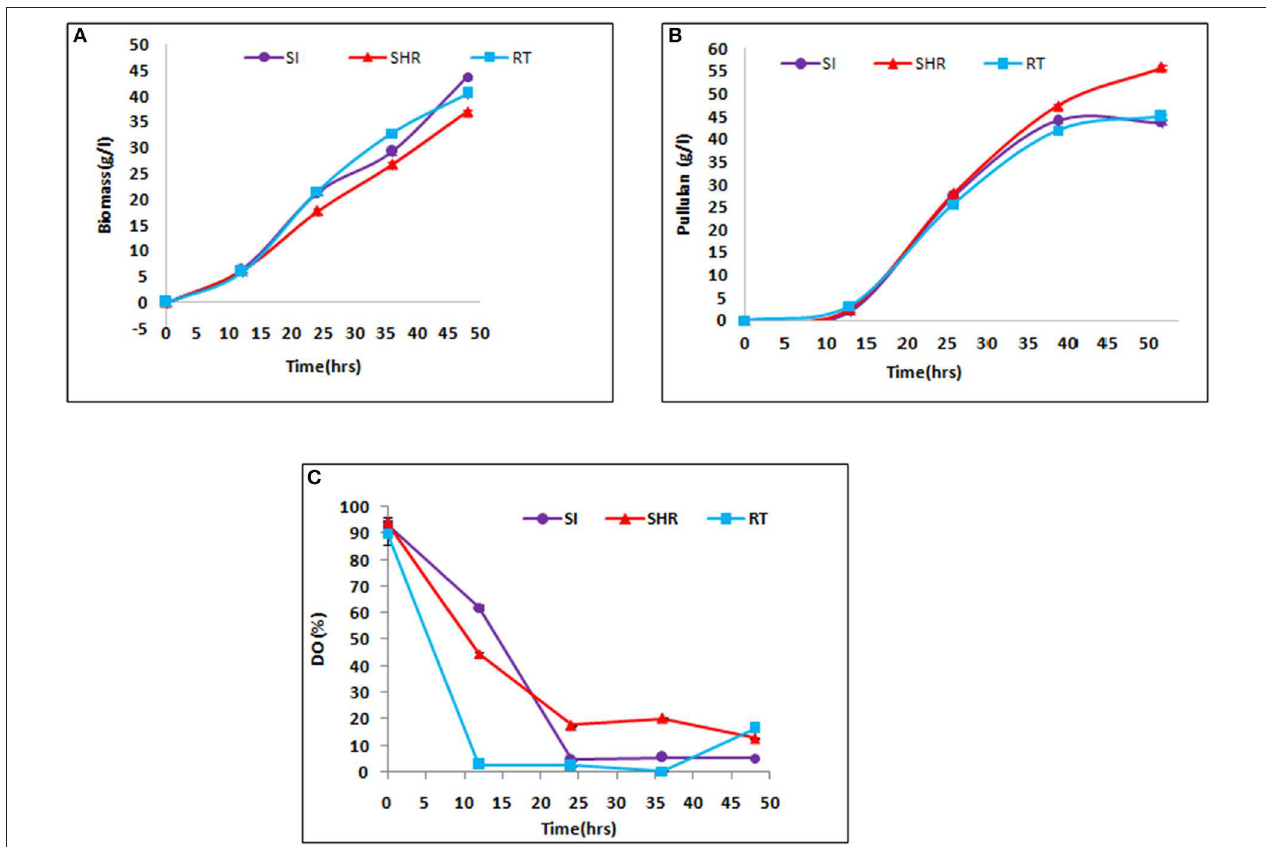
FIGURE 3 | Kinetics of fermentative production of pullulan by Aureobasidium pullulans RBF 4A3 with different impeller (A) biomass production, (B) pullulan production, and (C) Dissolved Oxygen (DO) profile. The above graphs represent the comparative effect of three impellers, viz, SHR, RT, and SI, on biomass, pullulan production, and DO profile during 48h of fermentation process. It is evident from (A,B) that SHR supports the least biomass formation as compared to the other two impellers, hence supporting the highest pullulan production of about 55 g/L.